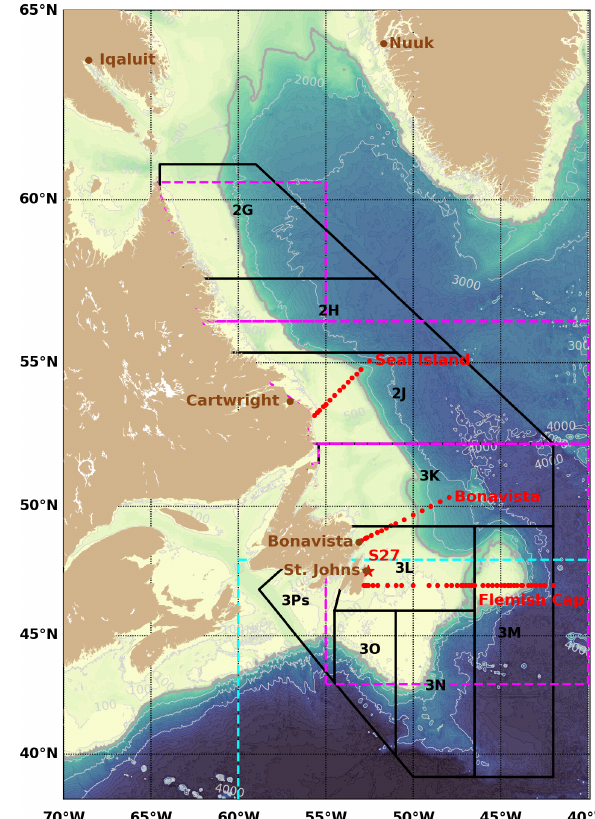
Figure 1. Map and main bathymetric features of the Northwest Atlantic ocean. NAFO Divisions (sub-areas 2 and 3) on the New- foundland and Labrador (NL) shelf are drawn. The AZMP hydro- graphic sections Seal Island, Bonavista Bay and Flemish Cap are shown with red dots. Long-term AZMP hydrographic Station 27 is highlighted with a red star. The five stations used for the air tem- perature time series are shown in brown. The three regions used for sea ice calculations are drawn with dashed magenta lines: northern Labrador shelf, southern Labrador shelf and Newfoundland shelf, respectively, from north to south. The region used by the IIP for iceberg sightings south of 48 ◦ N is drawn in dashed cyan. The shelf break is delimited by a thicker and darker contour corresponding to the isobath 1000m (used to clip the SST and bottom